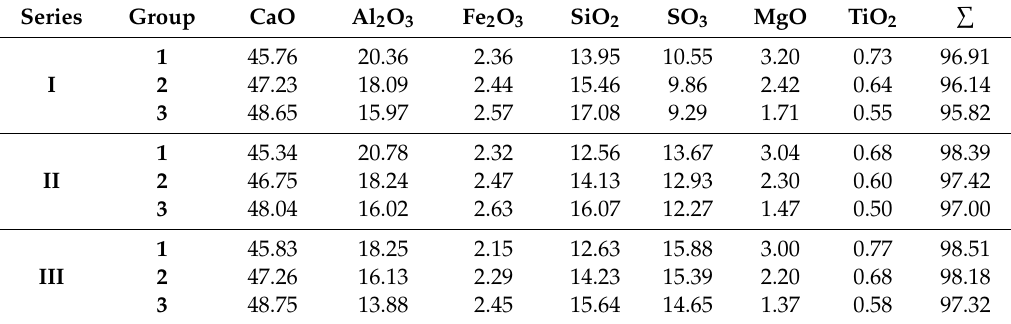
Table 3. Chemical composition of the cement clinkers, wt.%.